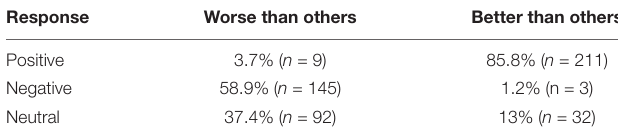
TABLE 4 | Emotional response: judgments being better or worse than others.